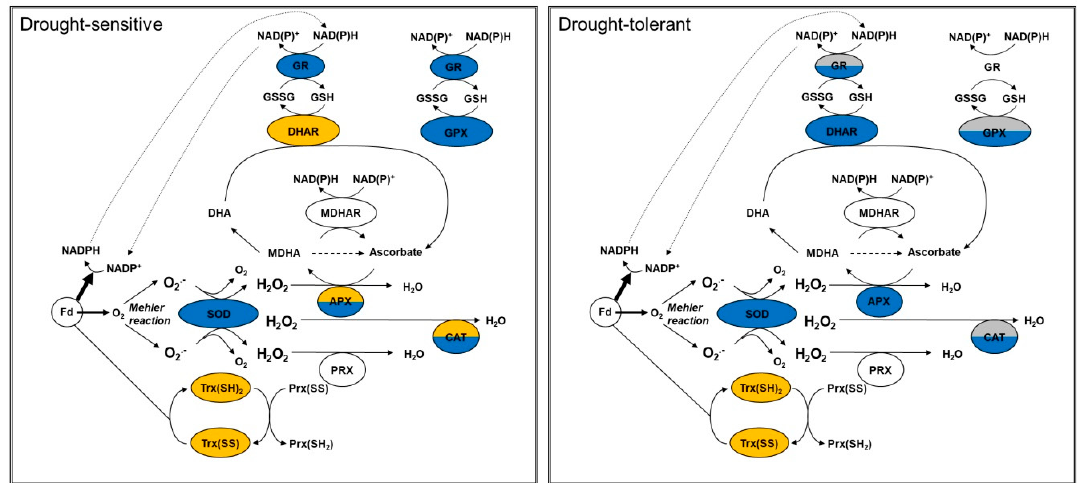
Figure 3. Changes in the activation of the antioxidative system in sensitive and tolerant species. Orange, downregulation, blue, upregulation, grey, no significant changes, no color, no data. APX, ascorbate peroxidase; CAT, catalase; DHAR, dehydroascorbate reductase; Fd, ferredoxin; GPX, glutathione peroxidase; GR, glutathione reductase; MDHAR, monodehydroascorbate reductase; PRX, peroxiredoxin; SOD, superoxide dismutase; TRX, thioredoxin.